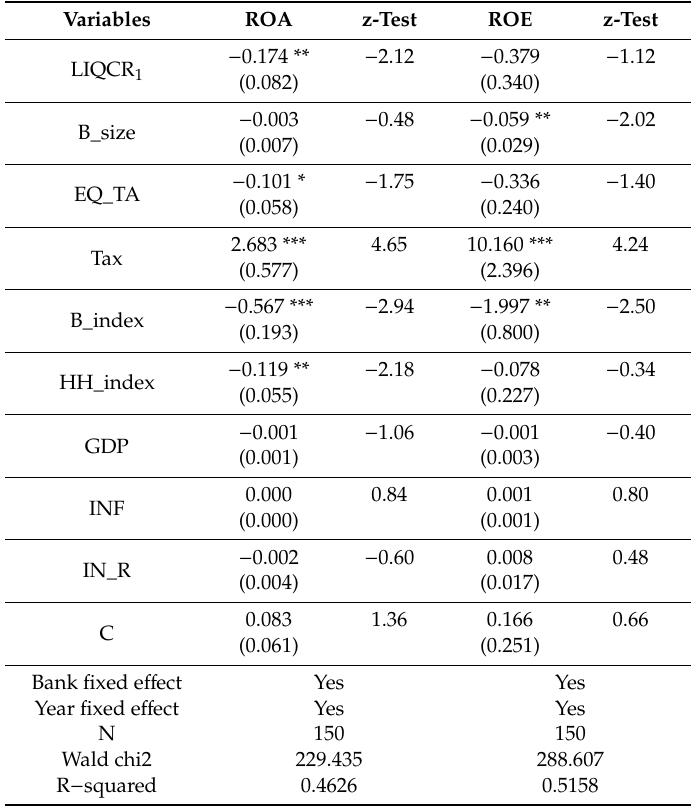
Table 6. Regression analysis on the relationship between liquidity creation and bank